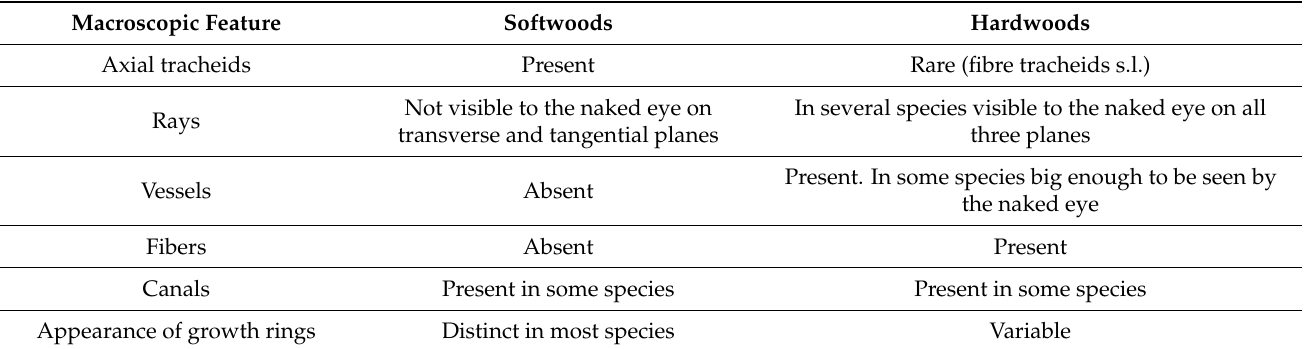
Table 3. List of macroscopic features of softwoods and hardwoods.